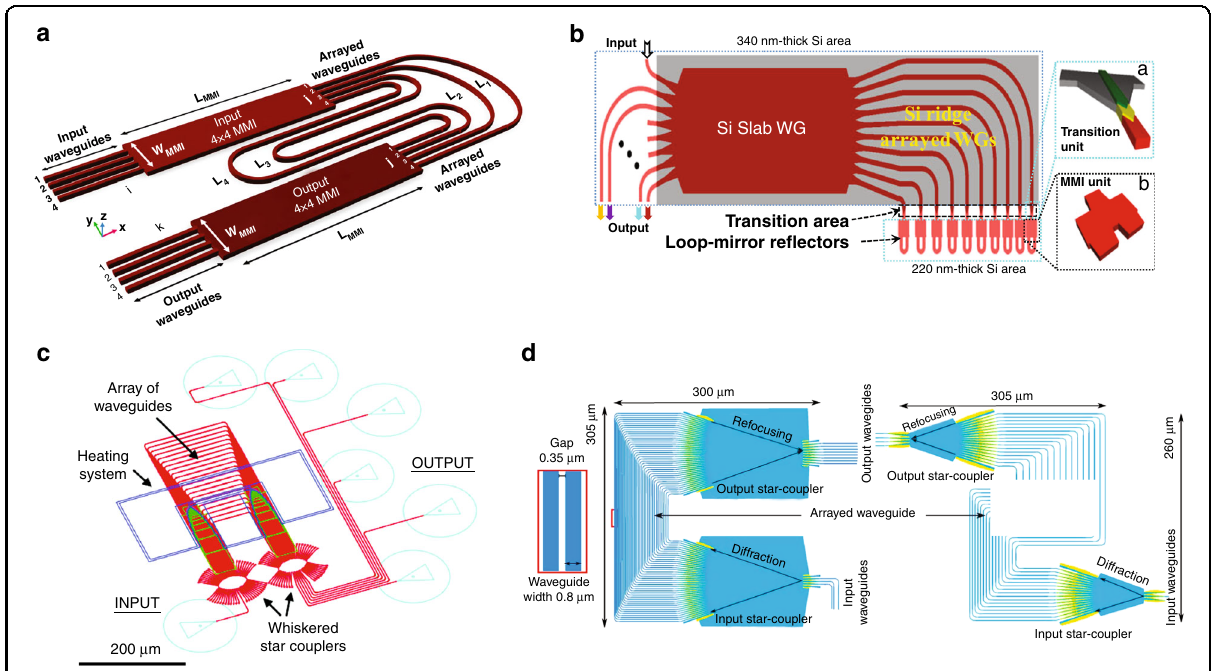
Fig. 8 AWG based spectrometers on silicon photonics platform. a AWG with MMIs for compact footprint 68 . b AWG with re fl ectors to reduce half of the size 70 . c , d AWGs with advanced star couplers and wide waveguides to reduce channel cross-talk 71,72 . a Adapted from ref. 68 with permission from IEEE Publishing. b Reprinted from ref. 70 with permission from IEEE Publishing. c Reprinted from ref. 71 with permission from IEEE Publishing. d Reprinted from ref. 72 with permission from IEEE